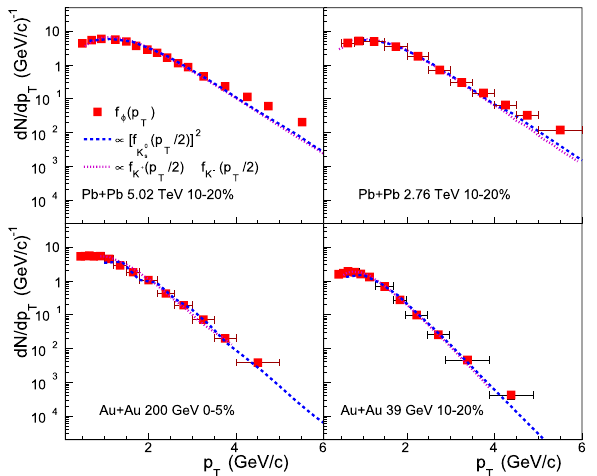
Fig. 10 The p T spectra by the coalescence of two kaons with equal velocity, which are compared with those of φ . Data of φ are taken from Refs.[47–50]andthoseofkaonsusedtocalculatetwo-kaoncoalescence are taken from Refs. [51–57]